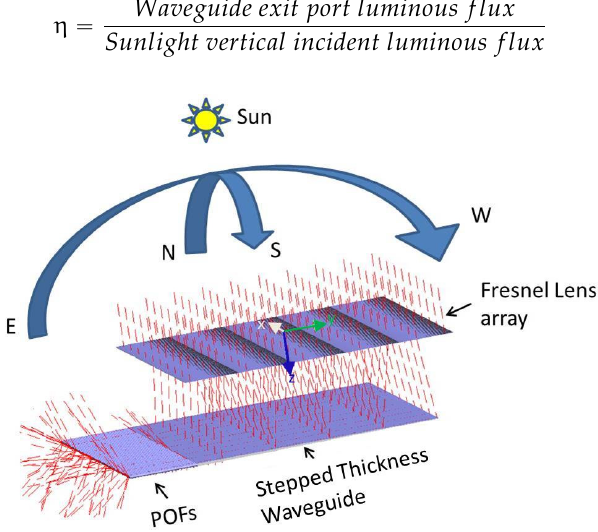
Figure 6. Illutration of the structure for the simulation.